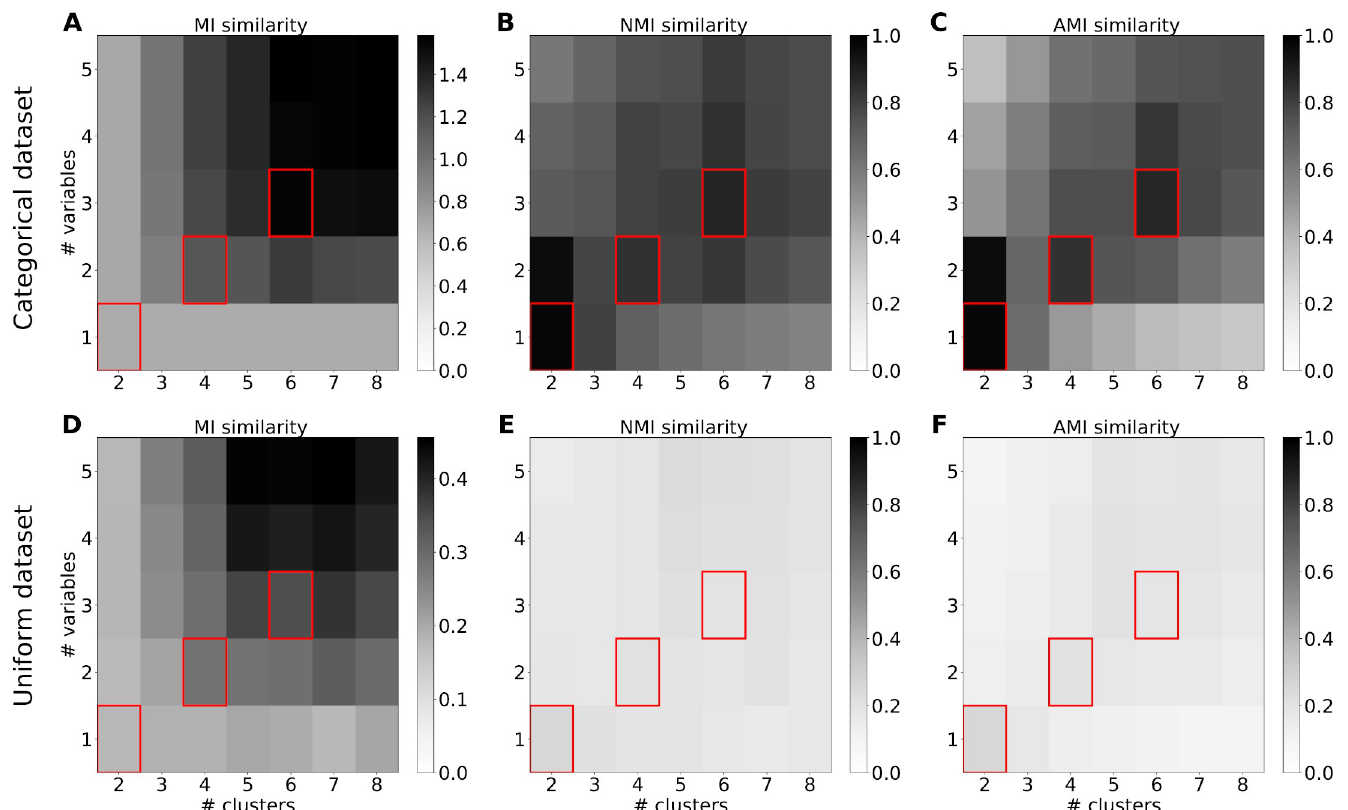
Fig 6. Comparison of different cluster similarity measures for spherical k-means partitions on synthetic data. Data were either categorical (top row) or non- categorical (bottom row) and simulated like in Figs 3 and 4. The similarity measure was either mutual information (A, D), normalized mutual information (B, E) or adjusted mutual information (C, F). The gray scale indicates the strength of similarity for given number of clusters and number of variables. Corresponding numbers of clusters and numbers of variables are marked in red.